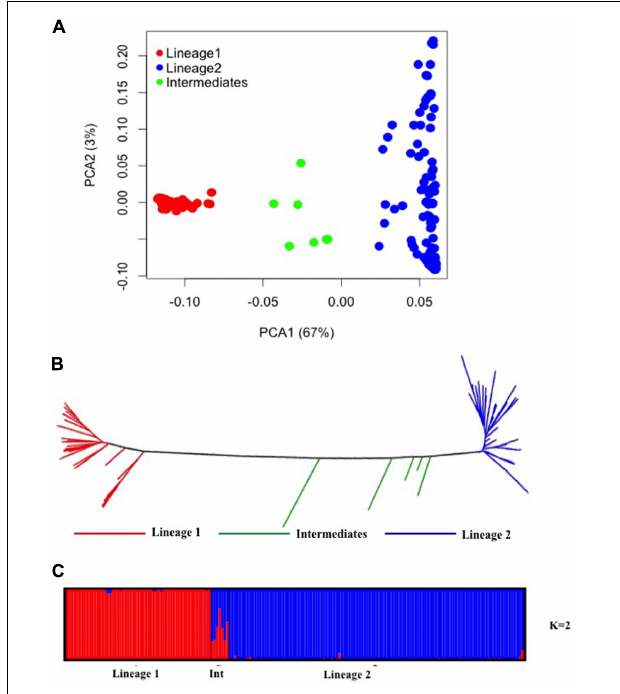
FIGURE 3 | Diversity analysis of Aegilops tauschii accessions based on GBS makers. (A) Principal component analysis. (B) Phylogenetic neighbor-joining tree. (C) Structure results at K = 2.